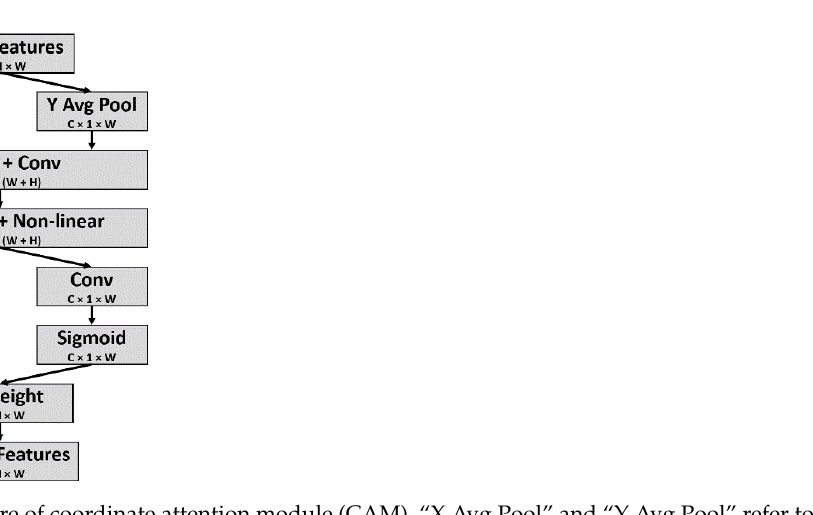
Figure 5. Structure of coordinate attention module (CAM). “X Avg Pool” and “Y Avg Pool” refer to 1D horizontal global pooling and 1D vertical global pooling, respectively.